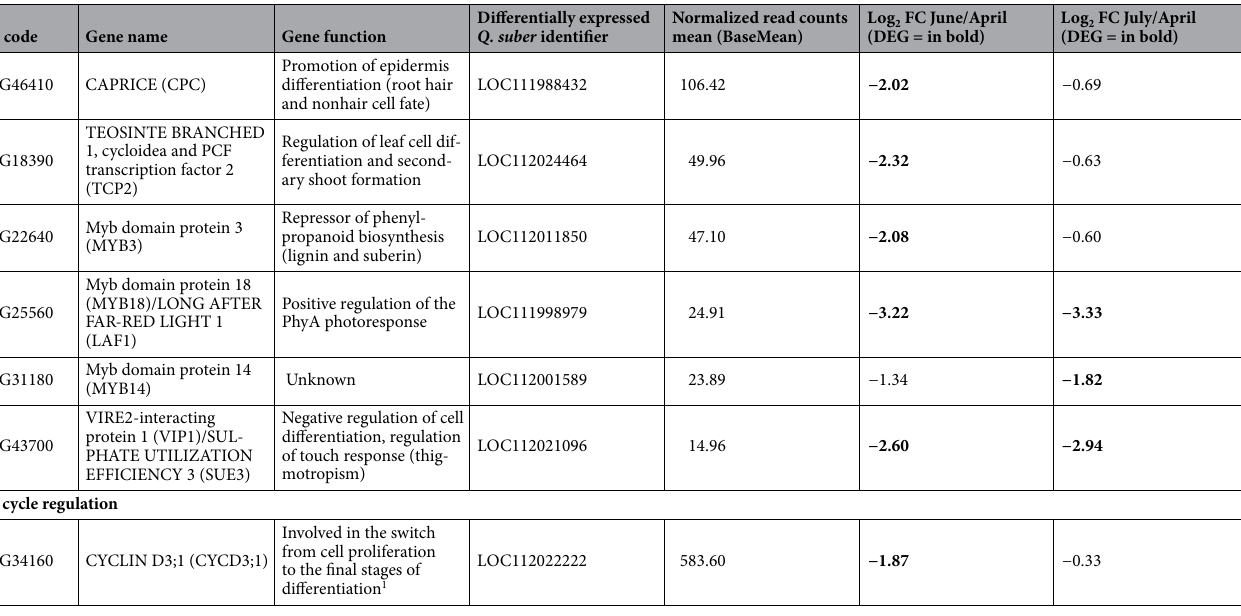
Table 1. Selection of candidate genes for phellogen (cork cambium) regulation classified into Meristem development, Cell differentiation and Cell cycle regulation categories that were upregulated at the beginning of the cork growing season (April, in cluster 2). They are sorted by highest expression (Normalized read counts mean) within each category. The complete list is presented in Supplemental Data Set 2. 1 Involved in vascular cambium development. 2 Highly expressed in vascular cambium (Zhang et al., 2019). 3 Not differentially expressed and thus not included in cluster 2, but being at the limit of the threshold (absolute log2Fold Change > 1) to be considered differentially expressed. 4 Related with chromatin/chromosome organization. 5 Included in cluster 2 but only DEG in